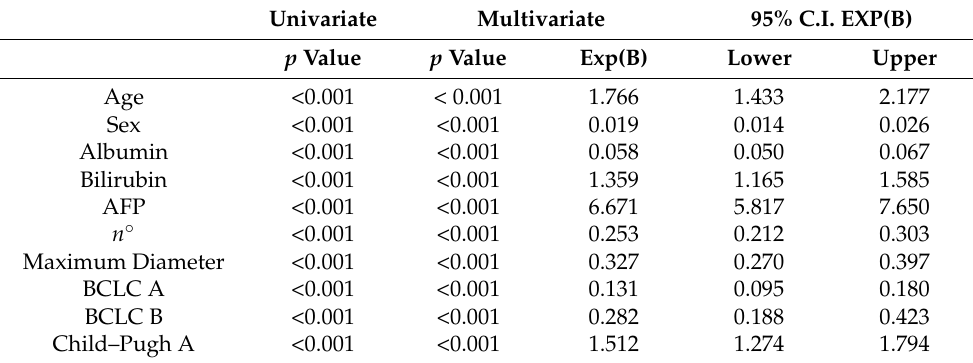
Table 7. Cox regression analysis—clinical variable association with